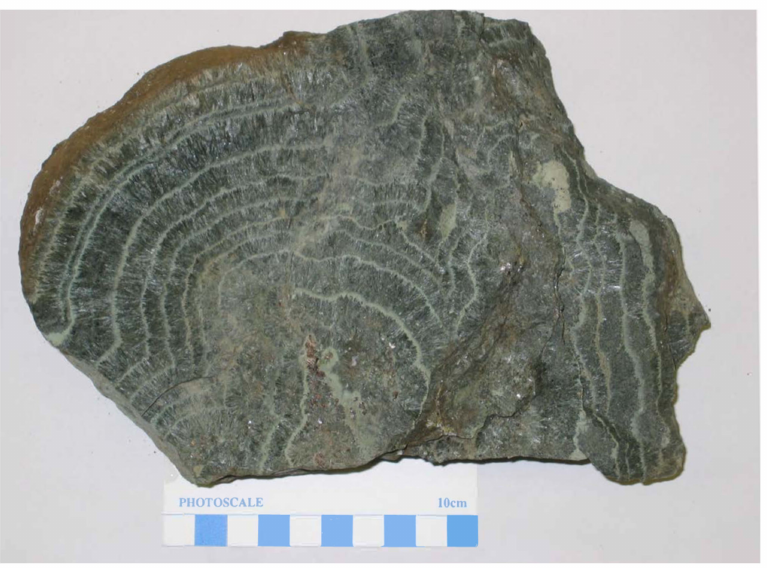
Figure 2. A typical Mokuji ore (hedenbergite with sphalerite and galena) from Maebira, − 315 mL, 5 Otsu-3 of the Tochibora